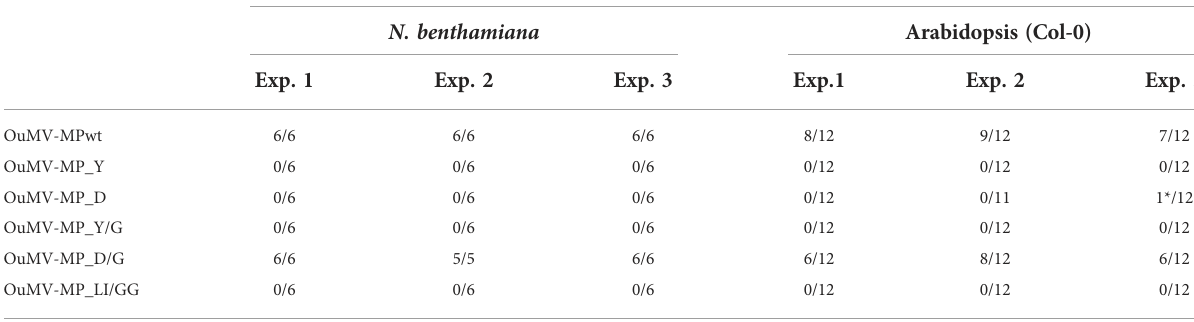
TABLE 1 Infectivity assays of OuMV carrying MPwt or MP mutants in N. benthamiana and Arabidopsis a . Virus Systemically infected plants/total inoculated